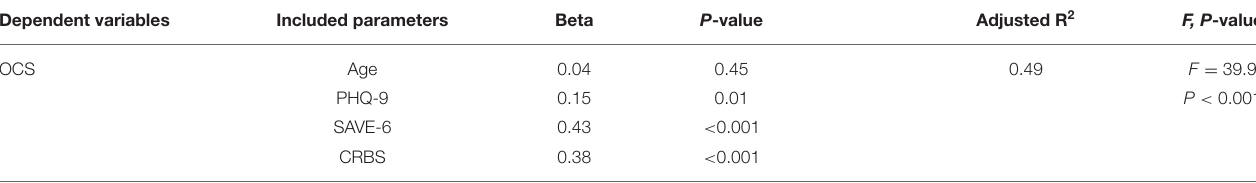
TABLE 3 | Linear regression analysis expecting obsession with COVID-19 among medical